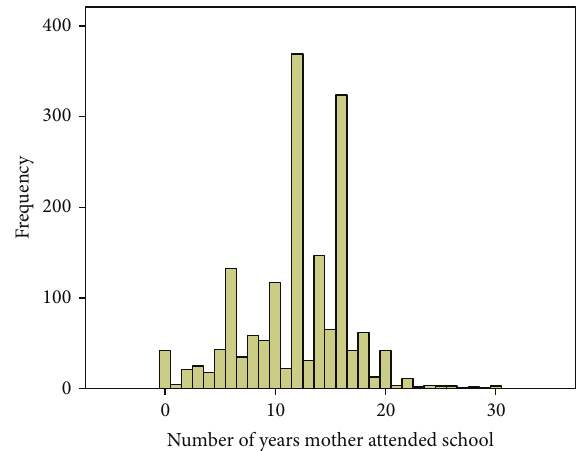
Figure 3: Histograms of raw data for the number of years the participant’s mother attended school.